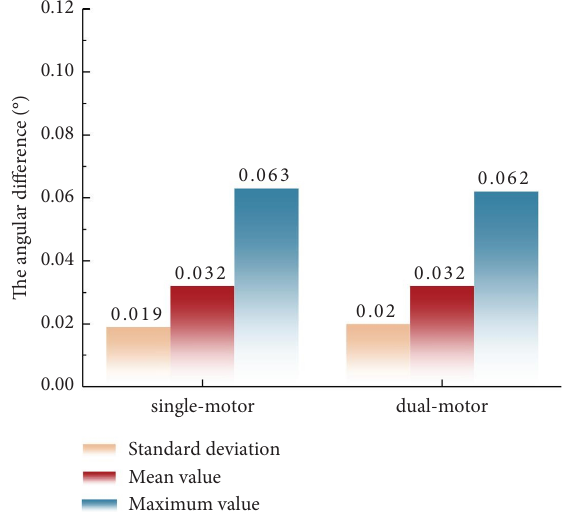
Figure 16: Te error caused by the centerline deviation of the bearings.